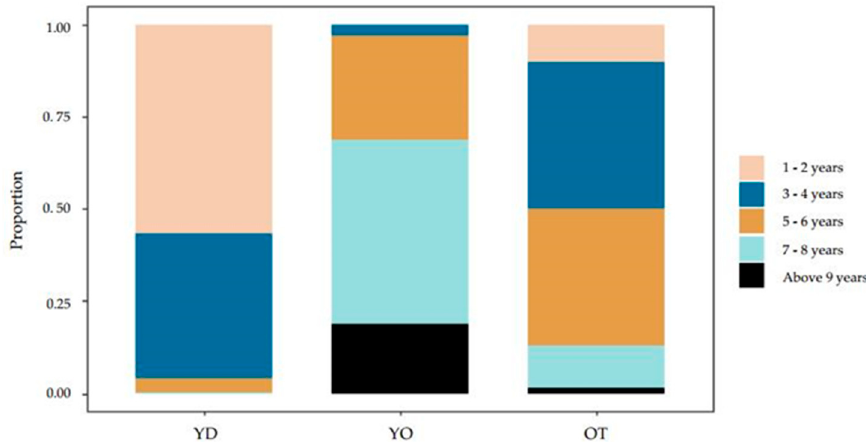
Figure 5. Temporal distribution of branch occlusion. YD and YO are the year of branch death and occlusion, respectively. OT is the time of branch occlusion.